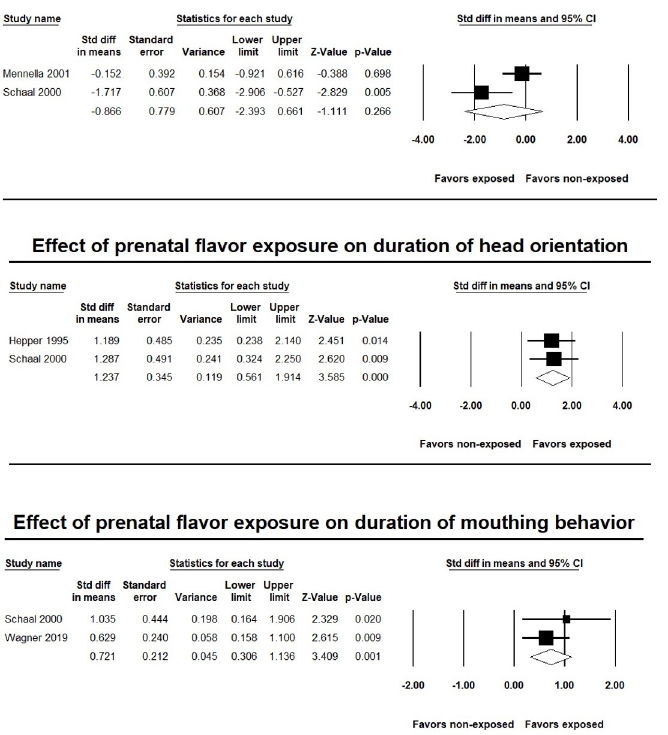
Fig 2. Forest plot of meta-analysis in the first group of studies. Diamonds represent the overall effect sizes, with squares representing individual studies. The size of the squares represents the weights assigned to each study.